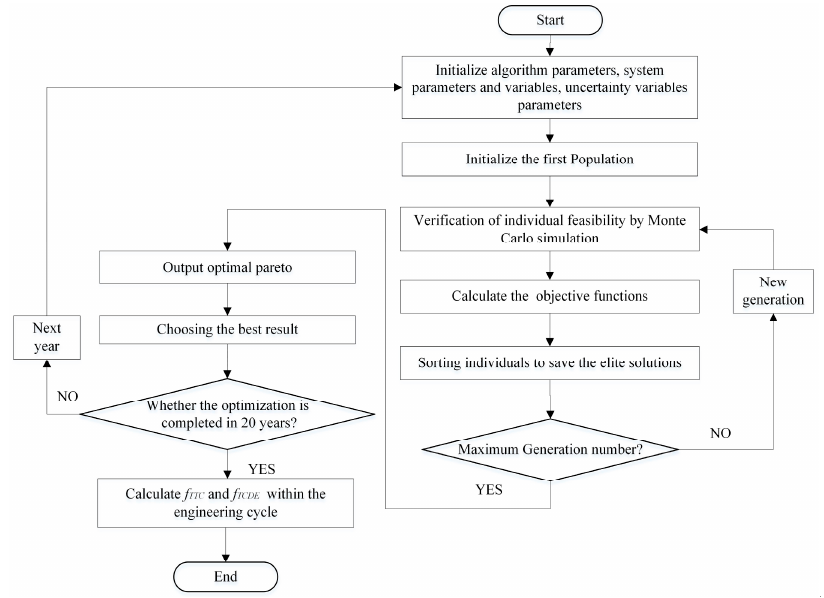
Figure 6. The flow chart of multi-objective stochastic optimization.